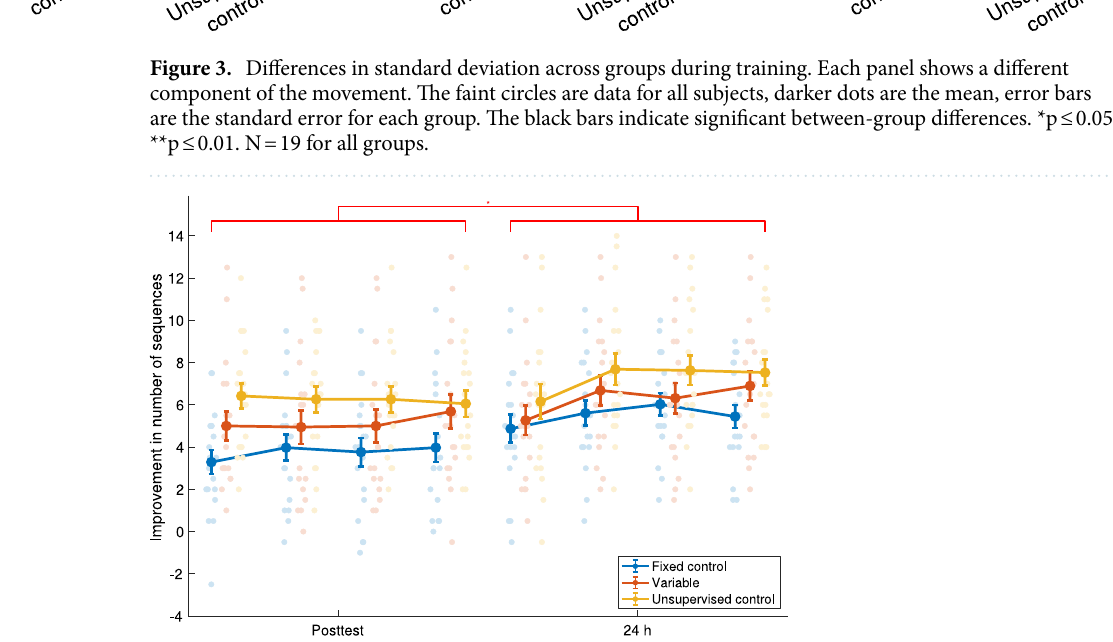
Figure 4. Improvement in number of sequences (relative to the mean number performed in the first two blocks of the Pretest). The faint dots are the values for all subjects (for each of the four Pretest or Posttest trials), the darker lines and error bars are the mean ± standard error. The red bar indicates a significant between-session difference. A main effect of group was also observed: the Unsupervised control group showed significantly greater improvement than the Fixed control group. N = 19 for all